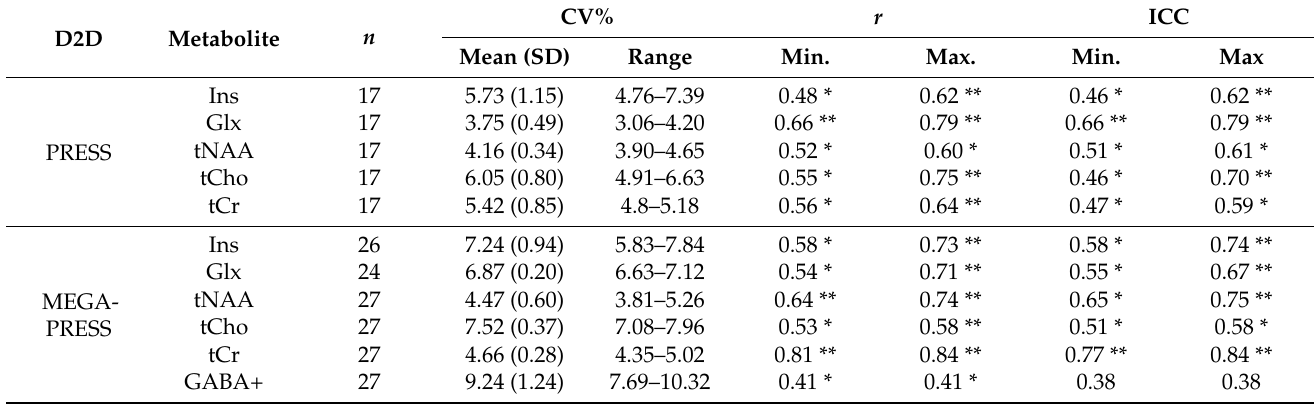
Table 3. PRESS and MEGA-PRESS D2D reproducibility metrics comparison. CV% includes mean (SD) and range of the four sets of D2D comparisons (D2D-S1; D2D-S2; D1S1D2S2; D1S2D2S1). The Min and Max r and ICC values, for the four sets of D2D comparisons, are reported, and their significance is given by the */** level. Only r and ICC values that are significant are included in the reported